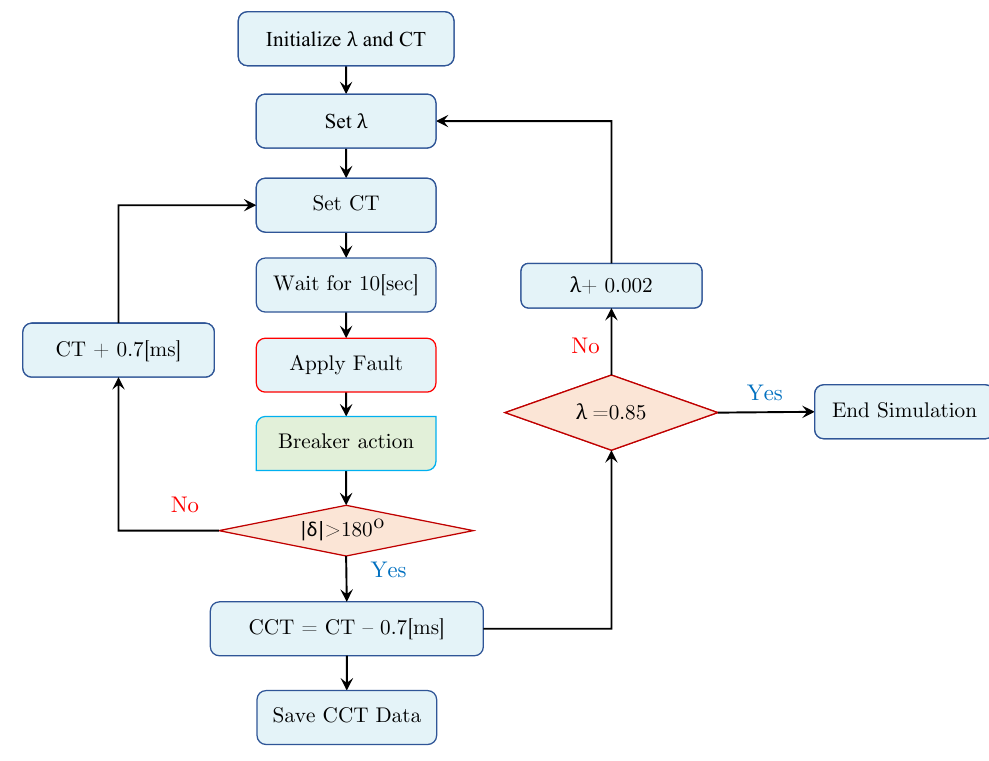
Figure 4. CCT data acquisition flowchart.